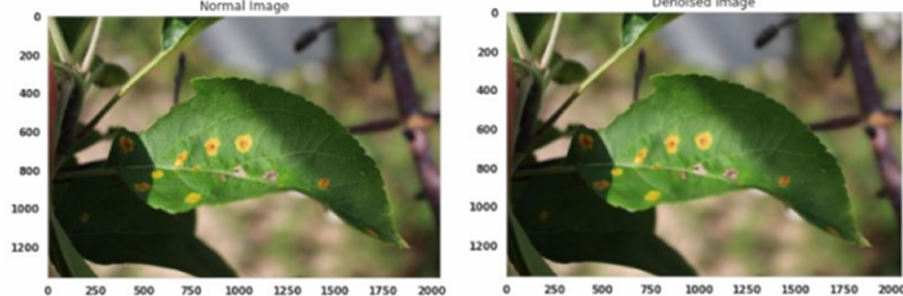
Figure 3. Applying the De-noising Filter on